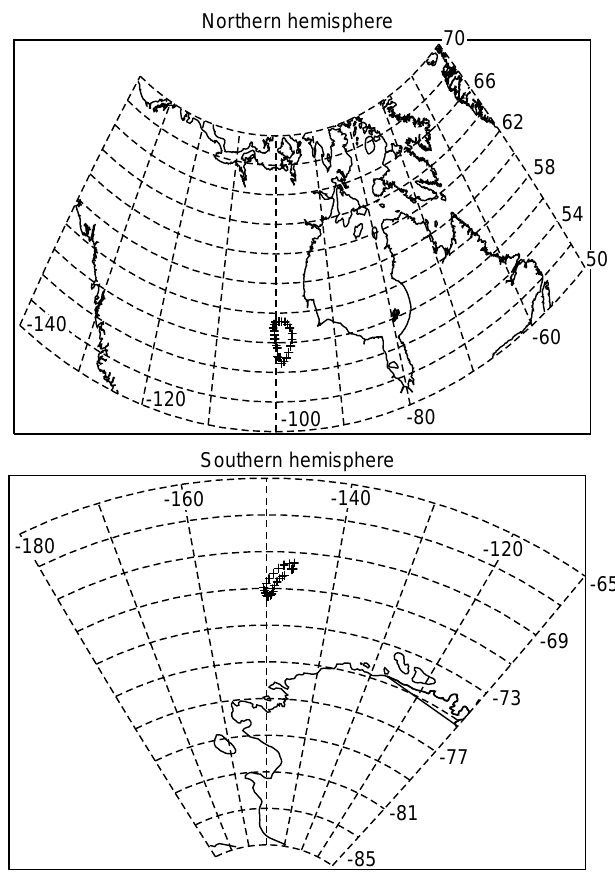
Fig. 3. Footpoints of the field lines in the Northern and Southern Hemisphere. The coordinates are given in a geographic coordinate system